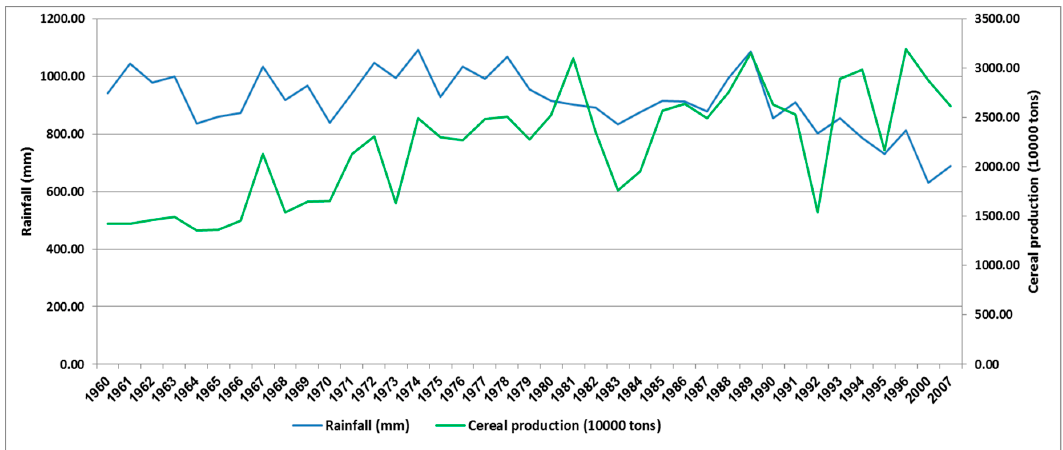
Figure 5. Relationship between rainfall variability and cereal production in SADC countries. Source: Developed by authors from Regional Strategic Analysis and Knowledge Support System (ReSAKSS) data (www.resakss.org).